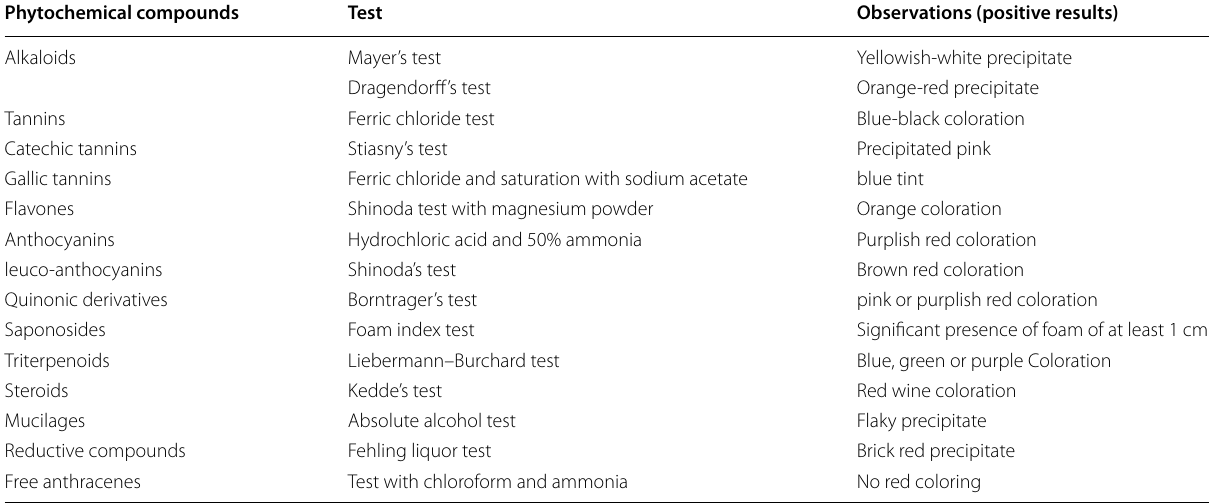
Table 1 Test for the detection of phytochemicals. Source : Houghton and Raman (1998) Phytochemical